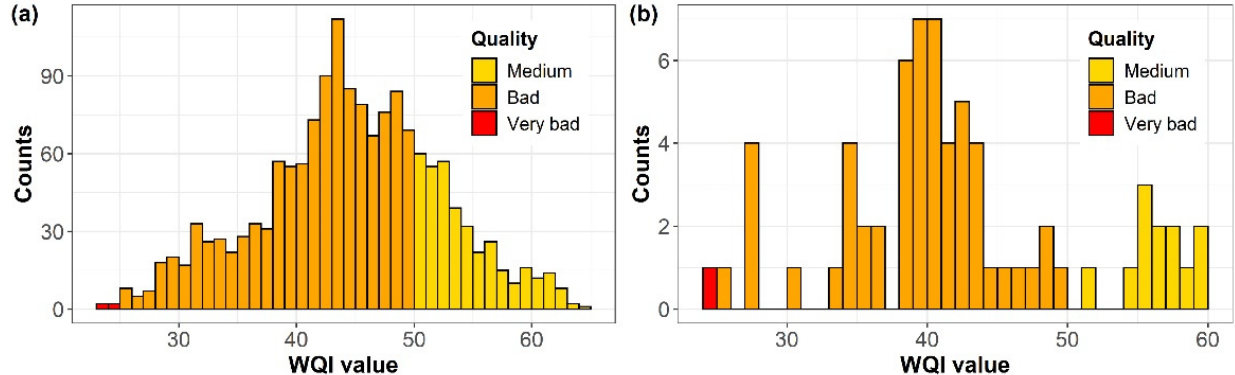
Figure 5. ( a ) Distribution of the WQI observations in the training data set; ( b ) distribution of the WQI observations in the testing data set.